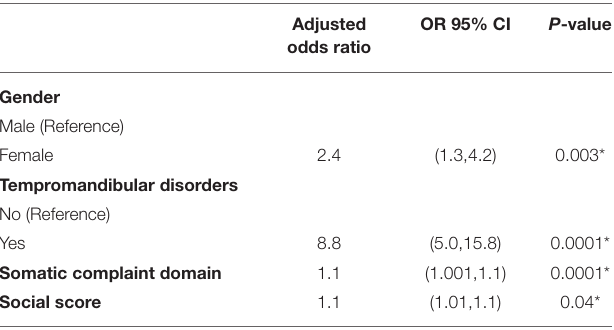
TABLE 3 | Logistic regression predicting self- reported TMD pain among adolescents in Jeddah, Saudi